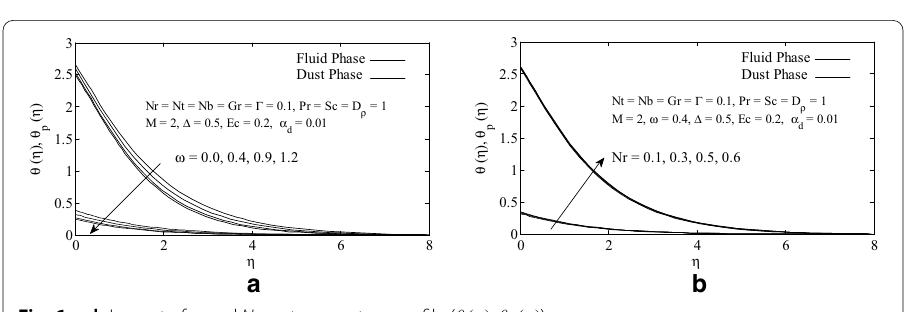
Fig. 6 a , b Impact of ω and Nr on temperature profile ( θ(η) , θ p (η)